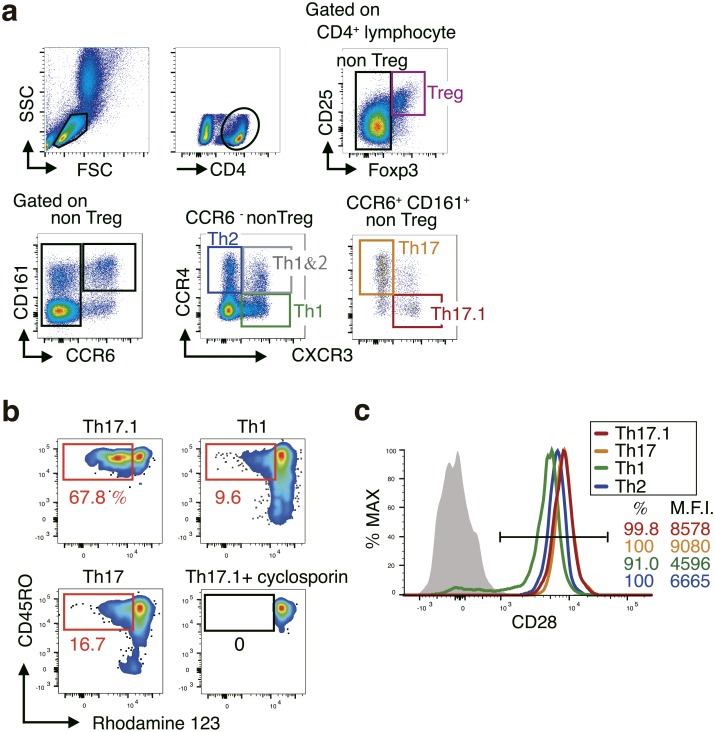
Characteristic of circulating Th17.1 cells in patients with rheumatoid arthritis (RA).a. Flow cytometry plots explaining the gating strategy for the identification of peripheral blood Treg, Th1, Th2, Th1&2, Th17, and Th17.1 subpopulations. CD4+ T cell subsets in the peripheral blood of adult patients with RA were analyzed using flow cytometry. b. The MDR-1 activity of the indicated Th subset assessed using multicolor flow cytometry with rhodamine 123 (Rh-123). Total CD4+ T cells isolated from the peripheral blood were labeled with Rh-123. After a 1-h efflux period at 37 °C in the presence of vehicle (dimethyl sulfoxide) or MDR-1 inhibitors (cyclosporine A), cells were stained with antibodies to CCR6, CXCR3, and CD45RO, and the Rh-123 efflux of each Th subset was analyzed using flow cytometry. Data shown are flow cytometry plots representing three independent experiments performed on cells isolated from different donors with RA. c. The proportion of cells with CD28 expression within the indicated CD4+ T cell subpopulations of patients with RA. Data are representative of at least three independent experiments.